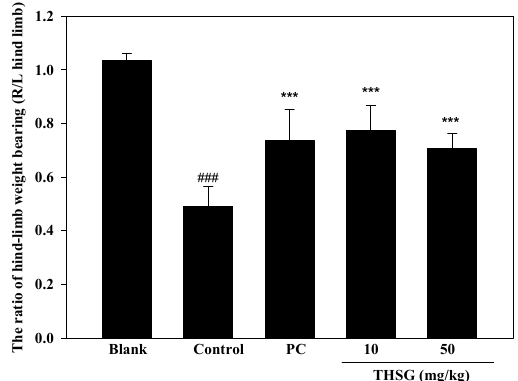
Figure 7. Hind-limb weight bearing ratio of rats on mono-iodoacetate (MIA)-induced osteoarthritis (day 7–day 0). #: control group compared to blank group, ### p < 0.005. *: sample group compared to control group, *** p < 0.005.